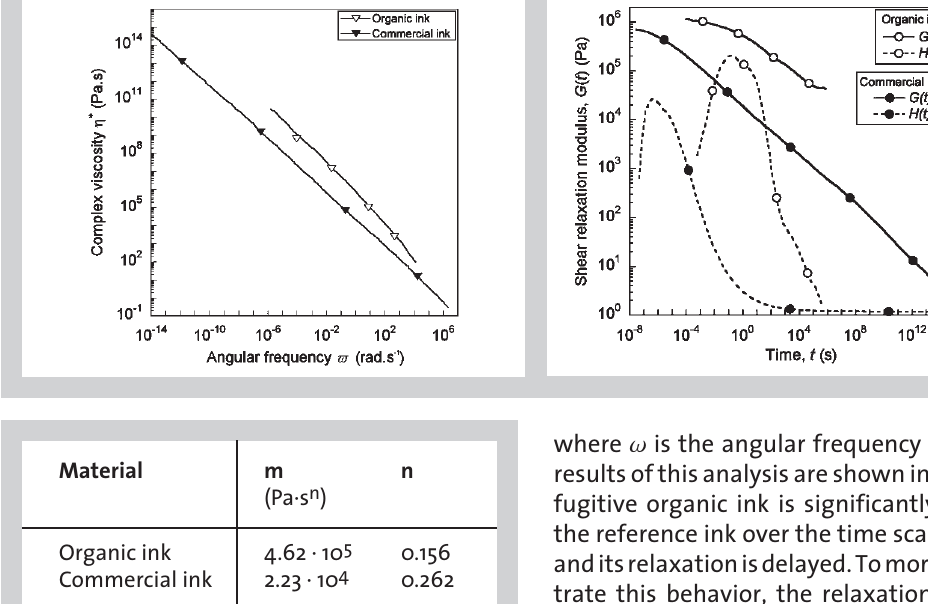
Figure 7 (left): Complex viscosity master curves for T = 25 ∞ C. ref Figure 8: Shear relaxation modulus (solid lines) and spectrum (dashed lines) as a function = 25 ∞ C. of time, T ref Table 3: Parameters of power-law representation of